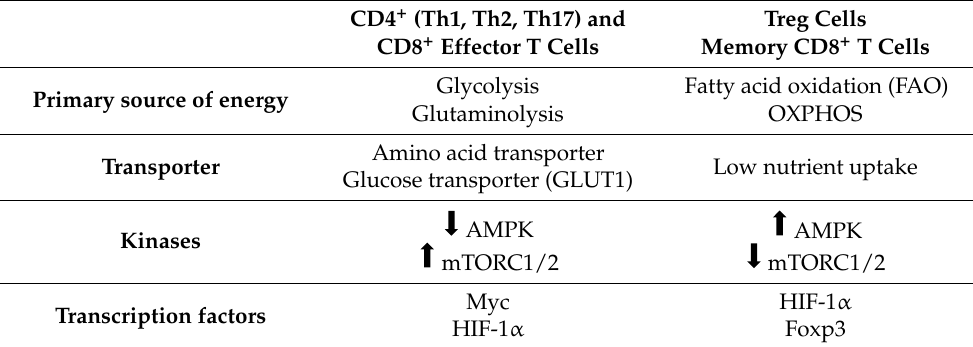
Table 1. Metabolic regulators of T-cell differentiation.